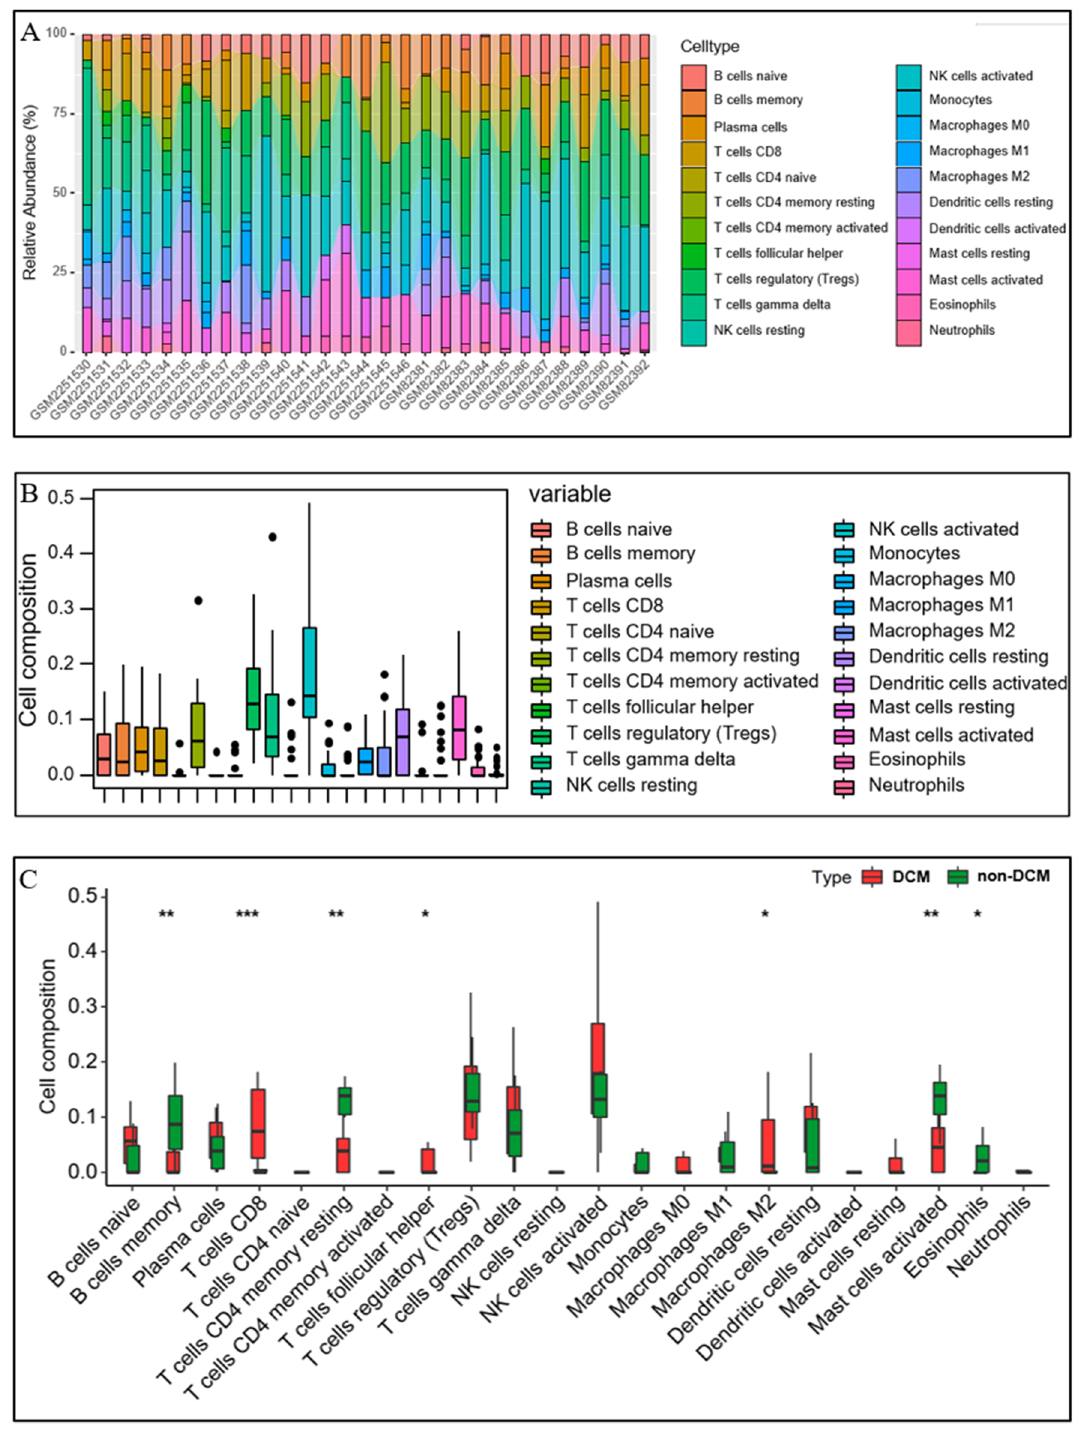
Figure 4. Immune infiltration analysis between DCM patients and non-DCM patients. ( A ) The percentage of twenty-two subpopulations of immune cells for each sample in DCM and non-DCM. ( B ) The percentage of twenty-two subpopulations of immune cells in total samples. ( C ) The difference of immune cells between DCM patients and non-DCM patients. DCM: dilated cardiomyopathy. * P < 0.05; ** P < 0.01; *** P <